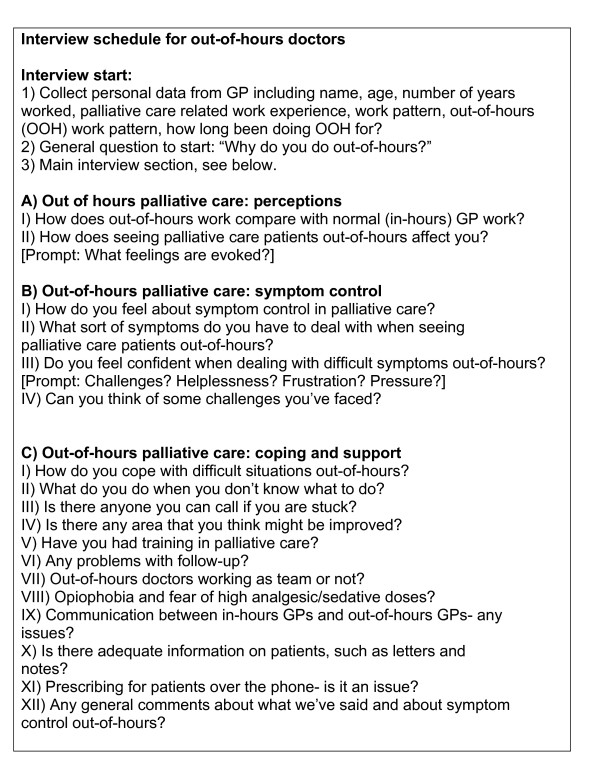
Interview Schedule